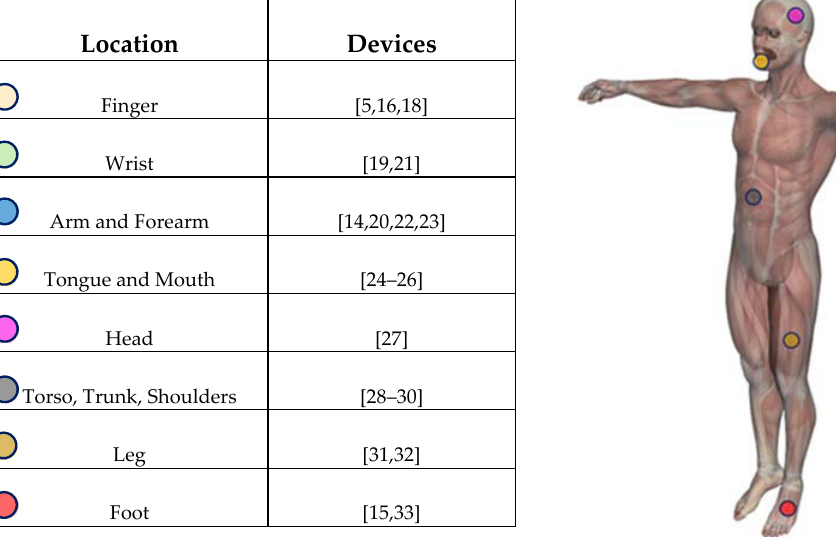
Figure 1. Wearable haptic systems and body locations. Finger [5,16,18]; wrist [19,21]; arm and forearm [14,20,22,23]; tongue and mouth [24–26]; head [27]; torso, trunk and shoulders [28–30]; leg [31,32]; foot [15,33].